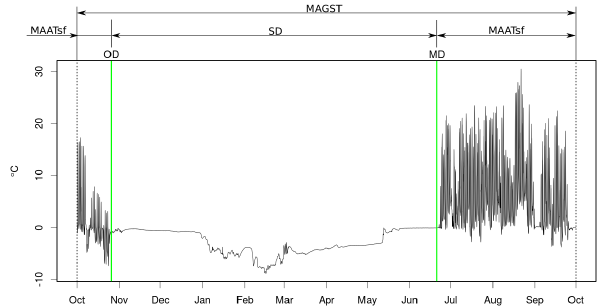
Figure 2. Example of detection of snow cover duration from GST time series with the method of Schmid et al. (2012). OD is the on- set date of snow; MD is the melting date of snow. The periods used for the calculation of MAGST, SD and MAATsf are represented by the scheme on top.